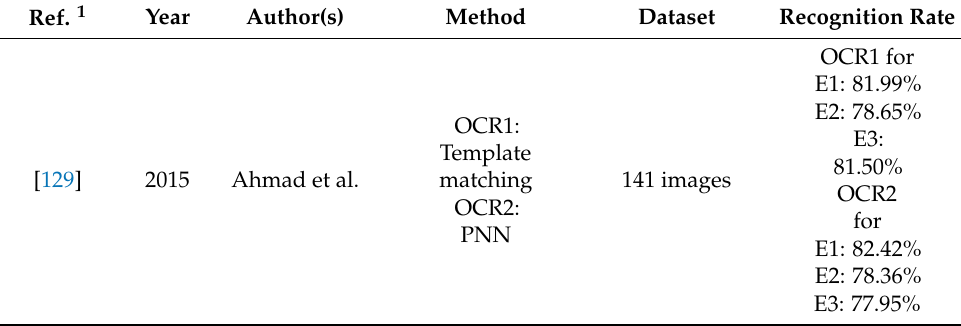
Table 2. ANPR Studies with CV Methods. Ref.